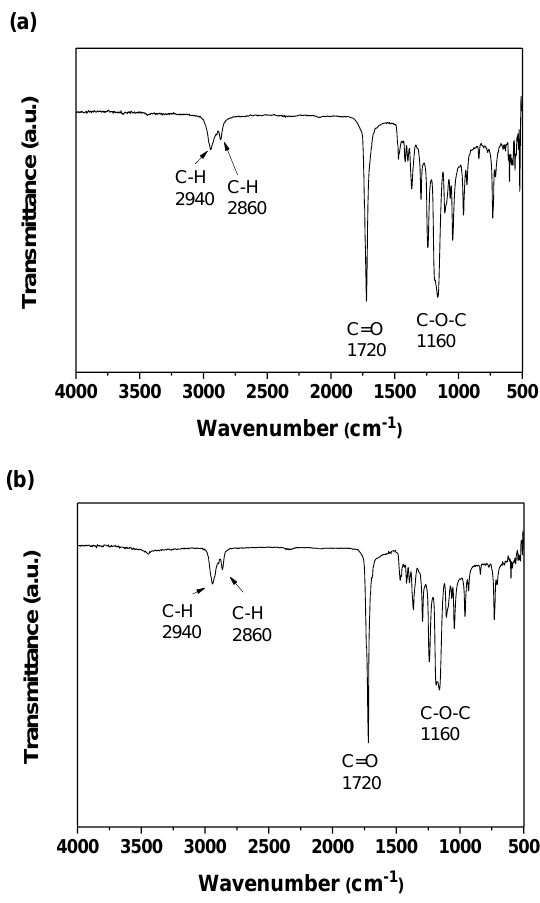
Figure 1. The ATR-FTIR spectra of the ( a ) 316L SS coated with a 2% PCL film and ( b ) 2% PCL film without coated on 316L ss.